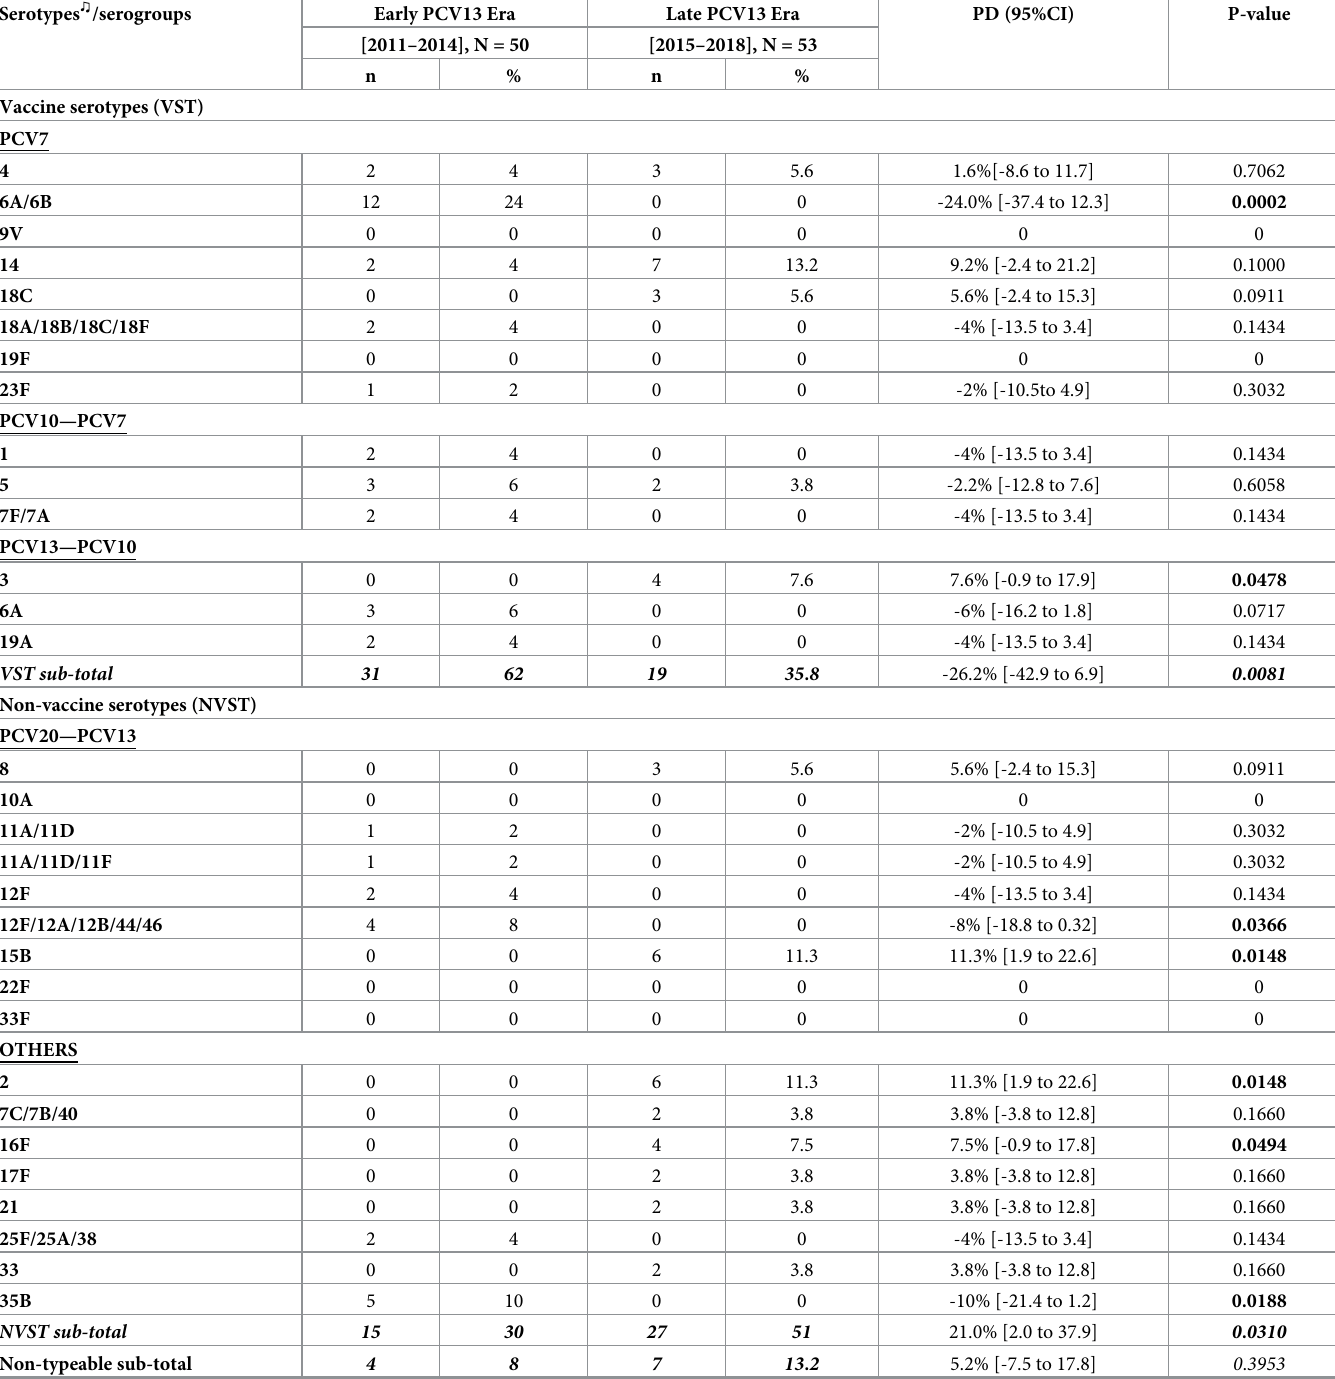
Table 5. Vaccine-type and non-vaccine type serotype distribution among 2-59 months old children hospitalized at the sentinel surveillance hospitals with con- firmed Pneumococcal Meningitis (PM) in Yaounde´: 2011—2018 (N = 103). Serotypes ♫